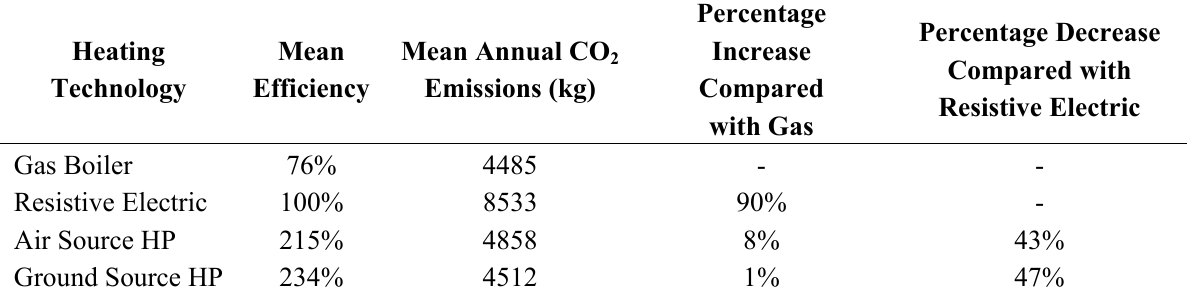
emissions for properties fitted with different heating Table 5. Annual CO 2